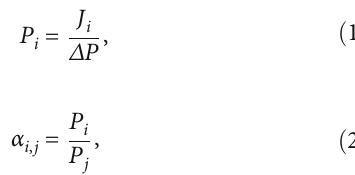
Table 1: Comparison of di ff erent zeolite membranes used for CO